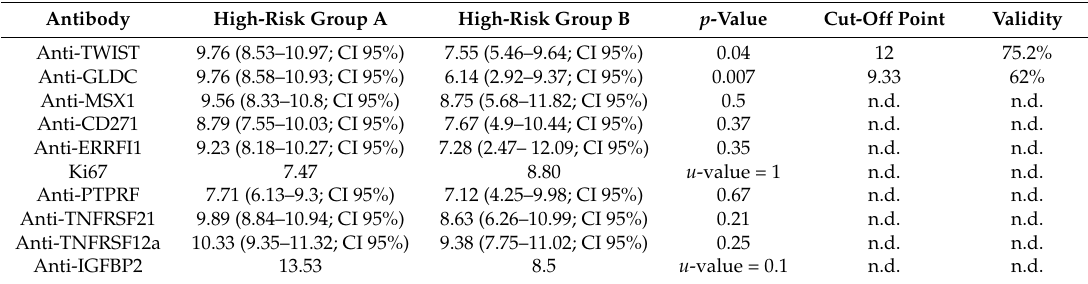
Table 4. Data comparison of high-risk group A (short term until metastasis) vs. high-risk group B (long term until